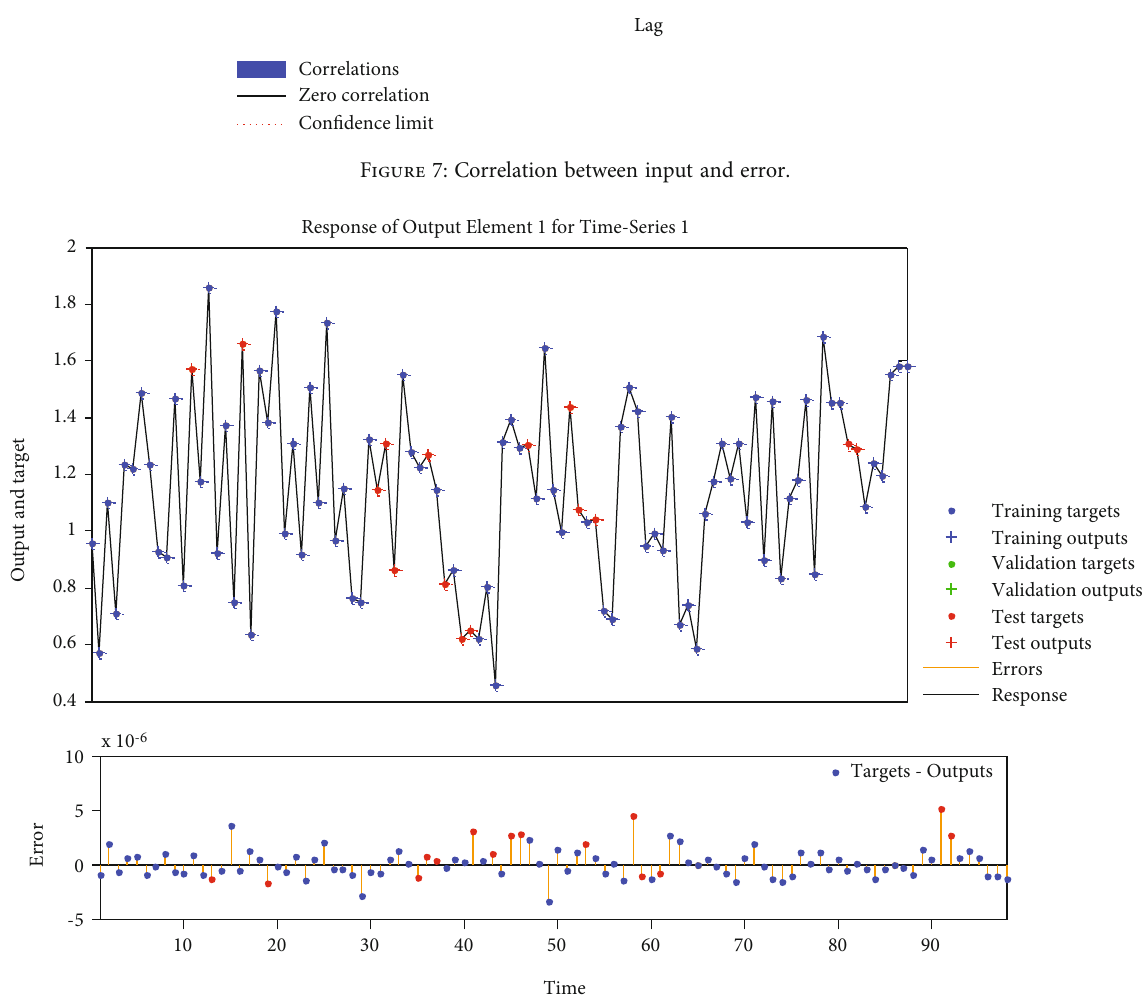
Figure 8: Output of the ResNet